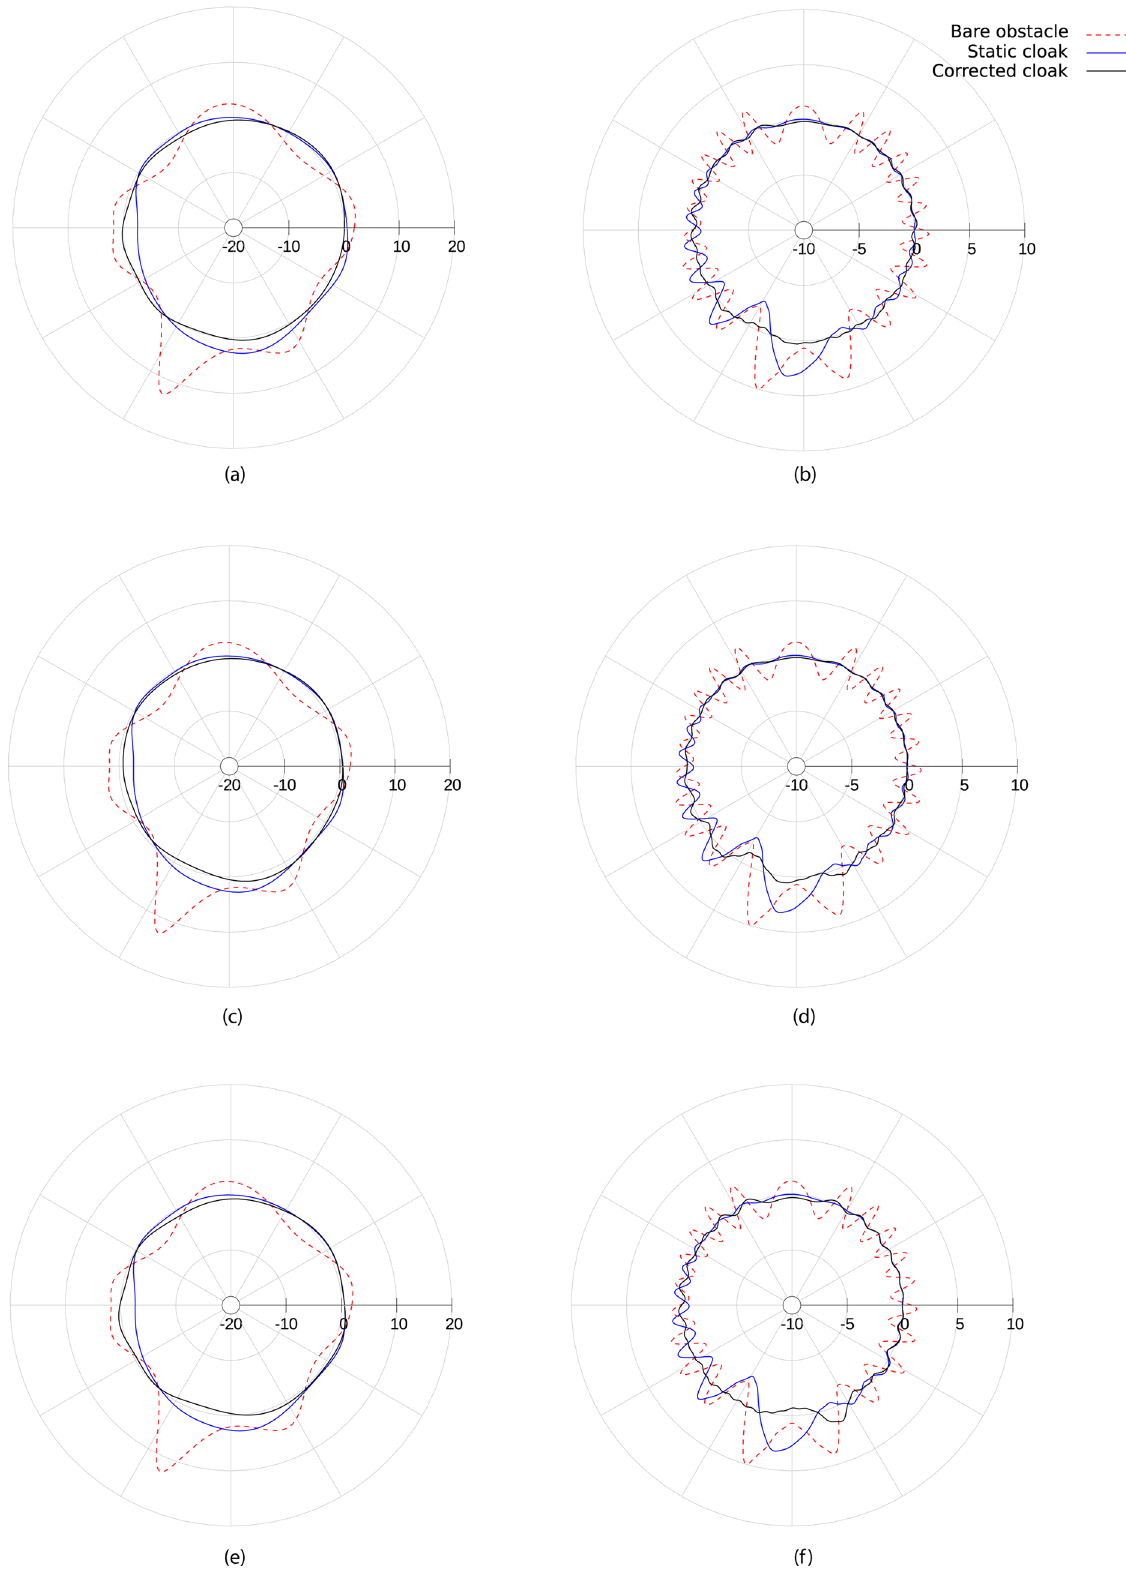
0.3 for kr 2 1.5 r 2 , ( a ), ( c ) and ( e )), and 4 in the near field ( r N Figure 5. Insertion Loss directivity at M mic = = F ∞ = 20 r 2 , ( b ),( d ) and ( f )). (cid:31) T is used in ( a ) and ( b ), (cid:31) TUS in ( c ) and ( d ), and (cid:31) PG in ( e ) and in the far field ( r mic = ( f ). Radial scale expressed in